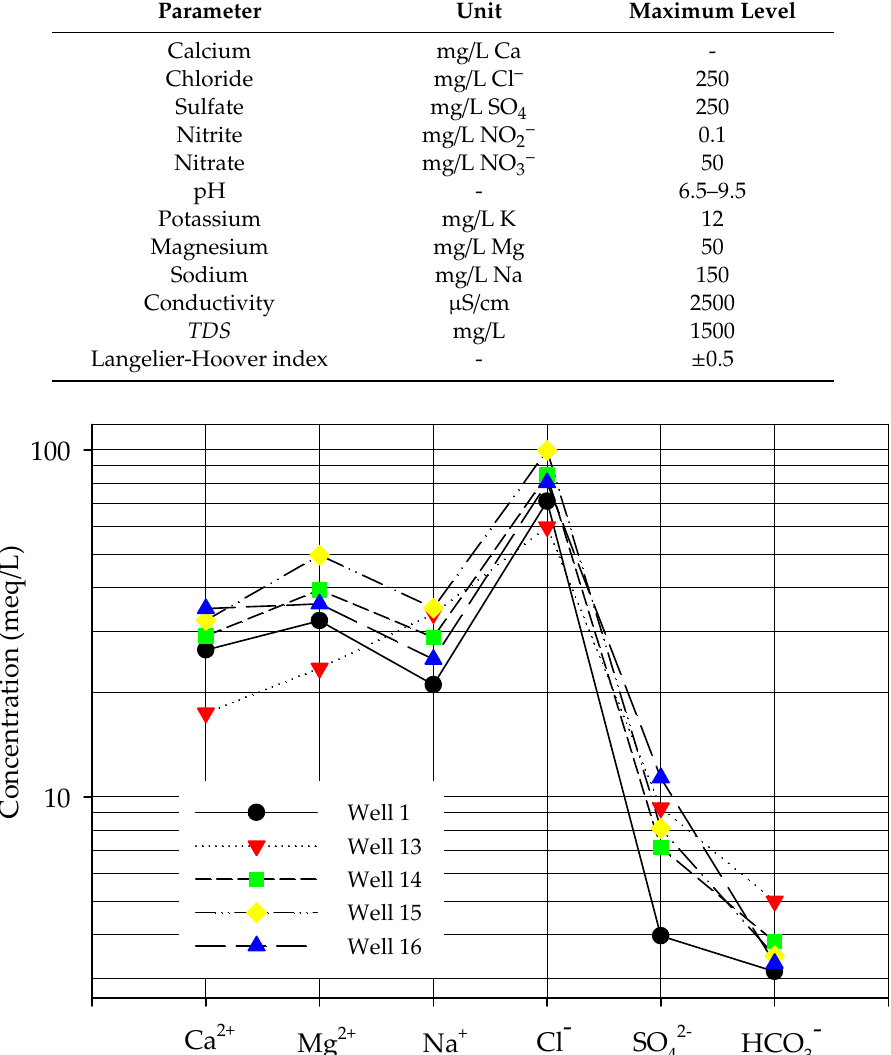
Figure 9. Schoeller diagram corresponding to Type I wells. Table 6. Maximum admissible levels of concentrations of the various parameters tested in a drinkable water in accordance with [44] .